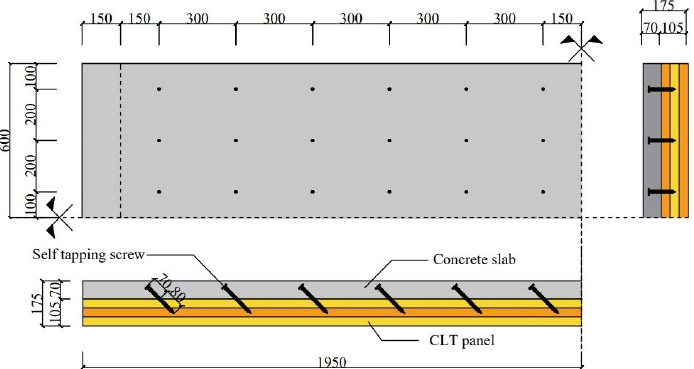
Figure 1. The arrangement of CLT–concrete composite board and distribution of screw connectors (units: mm). (units: